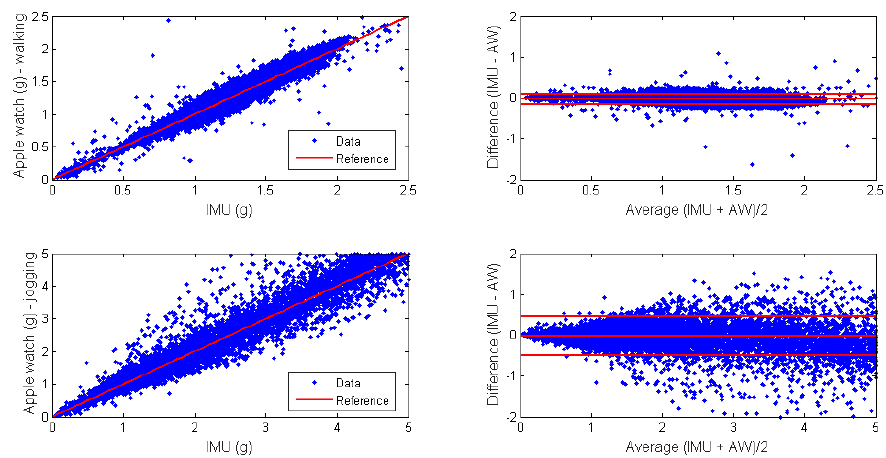
Figure 3. Correlation (left column) and Bland–Altman analysis (right column) for the Apple watch (AW) and IMU acceleration data on walking (top row) and jogging (bottom